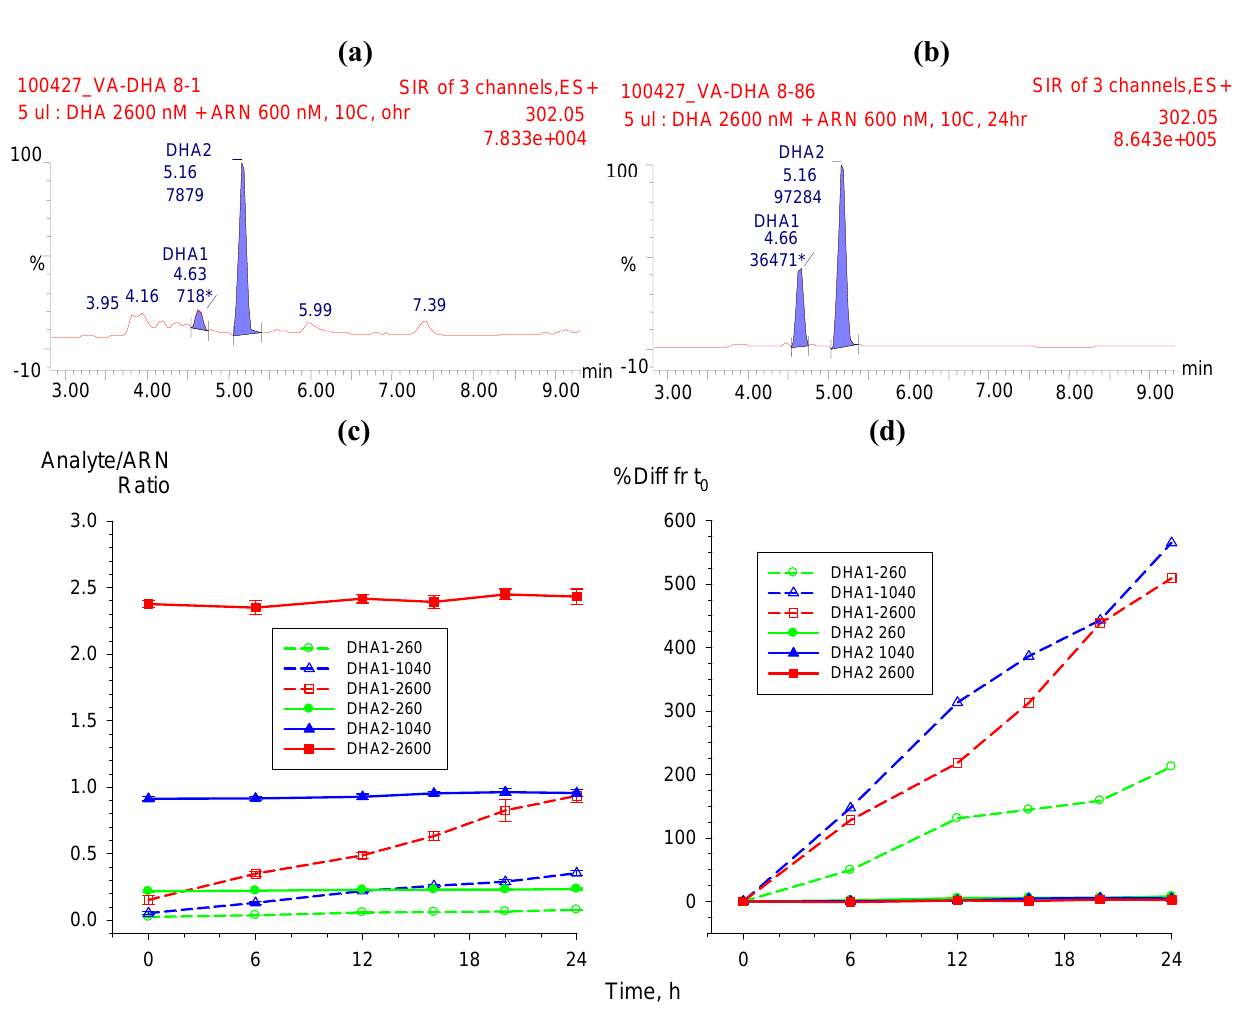
Figure 6. Post-preparative stability test of DHA in autosampler (10 °C) over 24 h period showing chromatograms (top panel) of α -DHA (t 4.6 min) and β -DHA (t 5.16 min) at ( a ) R R time 0 and ( b ) 24 h. ( c ) The mean (±95%CI) responses of five replicate analyses and ( d ) of both α - and β the % difference from t 0